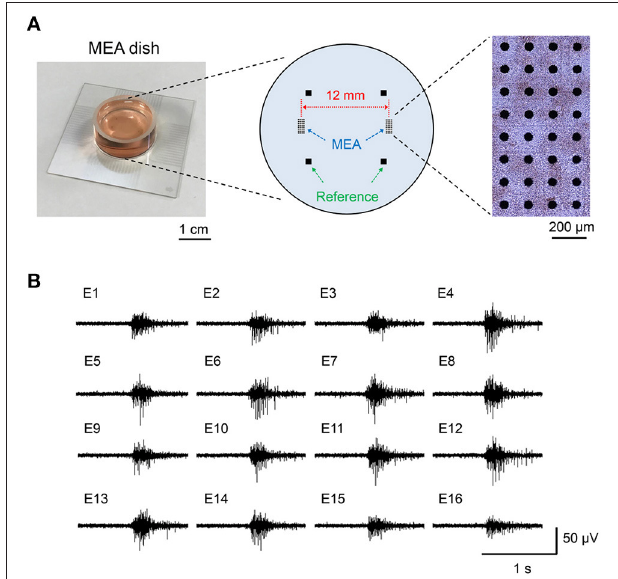
FIGURE 1 | Separate-type multi-electrode array (MEA) dish and synchronized bursting activity of cultured neuronal network. (A) Layout of the electrodes in separate-type MEA and the photograph of the cultured neuronal network on the MEA. (B) An example of extracellular potential of synchronized bursting activity recorded with the MED64